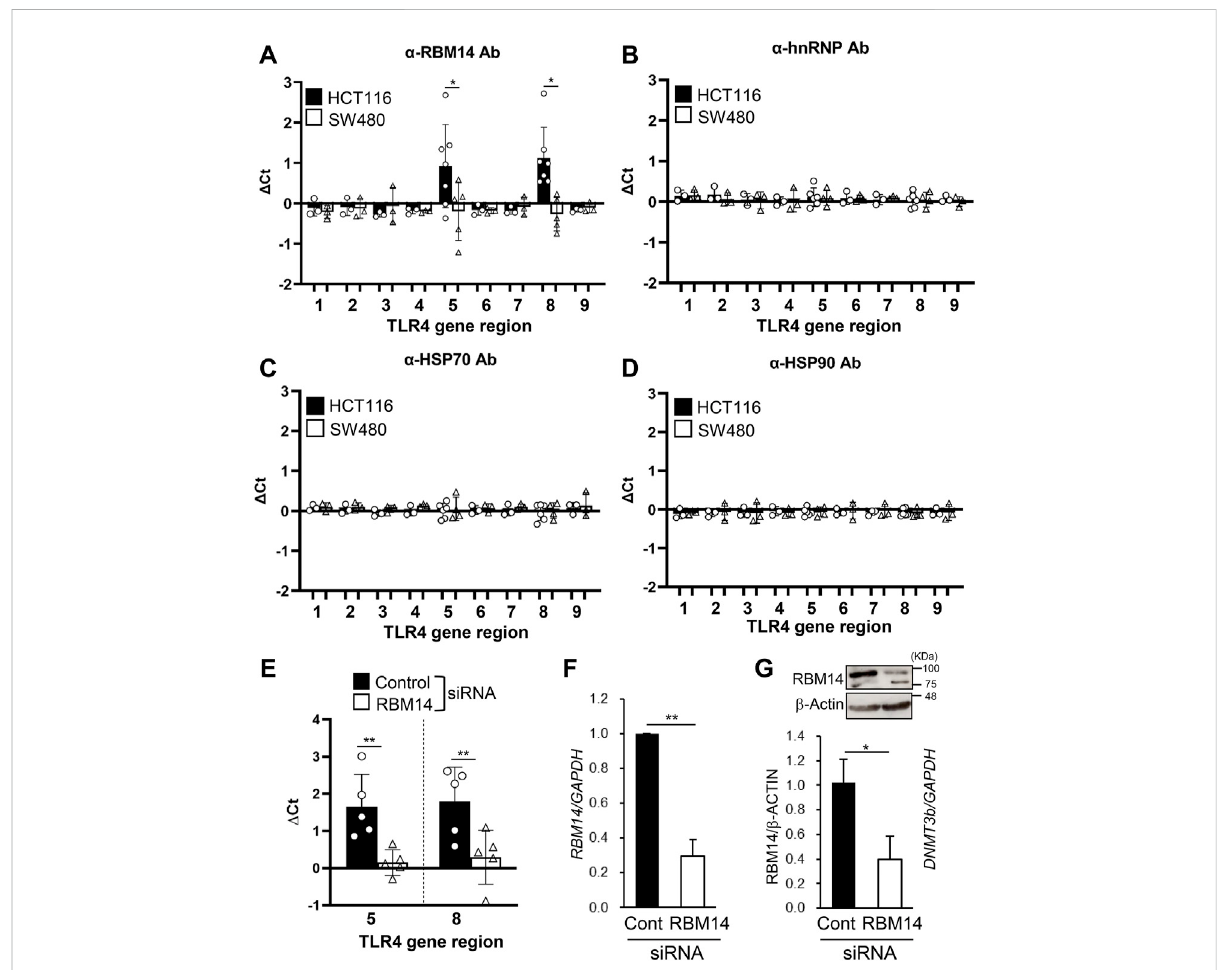
FIGURE 3 RBM14bindstotheTLR4geneintheIEClinewithhypermethylatedTLR4gene. (A – E) ChIPassaysofHCT116andSW480wereperformedusing antibodies against RBM14 (A) , hnRNP (B) , HSP70 (C) , and HSP90 (D) . Anti-DNMT3b antibody was used for ChIP assays in HCT116 cells treated with control or RBM14 siRNA (E) . PCR primers were prepared to cover the 5 ′ regions, nt − 6439/ − 6301 (region 1), − 5272/ − 5121 (region 2), − 4275/ − 4154 (region 3), − 3021/ − 2844 (region 4), − 1939/ − 1760 (region 5), − 739/ − 628 (region 6), and +75/+201 (region 7), and the 3 ′ regions, nt +10224/ +10408 (region 8) and +11243/+11417 (region 9), of the TLR4 gene. △ Ct was calculated by subtracting the Ct value of qPCR analysis of the precipitates with each antibody from that with corresponding isotype control antibody. Results are shown as mean ± SD of 3-7 independent experiments. *, ** Signi fi cantly different (* p < 0.05, ** p < 0.005). (F) RBM14 mRNA expression in HCT116 cells treated with negative control siRNA or RBM14 siRNA was determined using qRT-PCR. Relative expression levels to control cells are shown as mean ± SD of four independent experiments. ** Signi fi cantly different ( p < 0.001). (G) Expression of RBM14 in control or RBM14 siRNA-treated HCT116 cells was analyzed using western blotting. Representative blots (top) and mean ± SD of relative band intensities normalized to those of β -actin of three independent experiments (bottom) are shown. * Signi fi cantly different ( p <